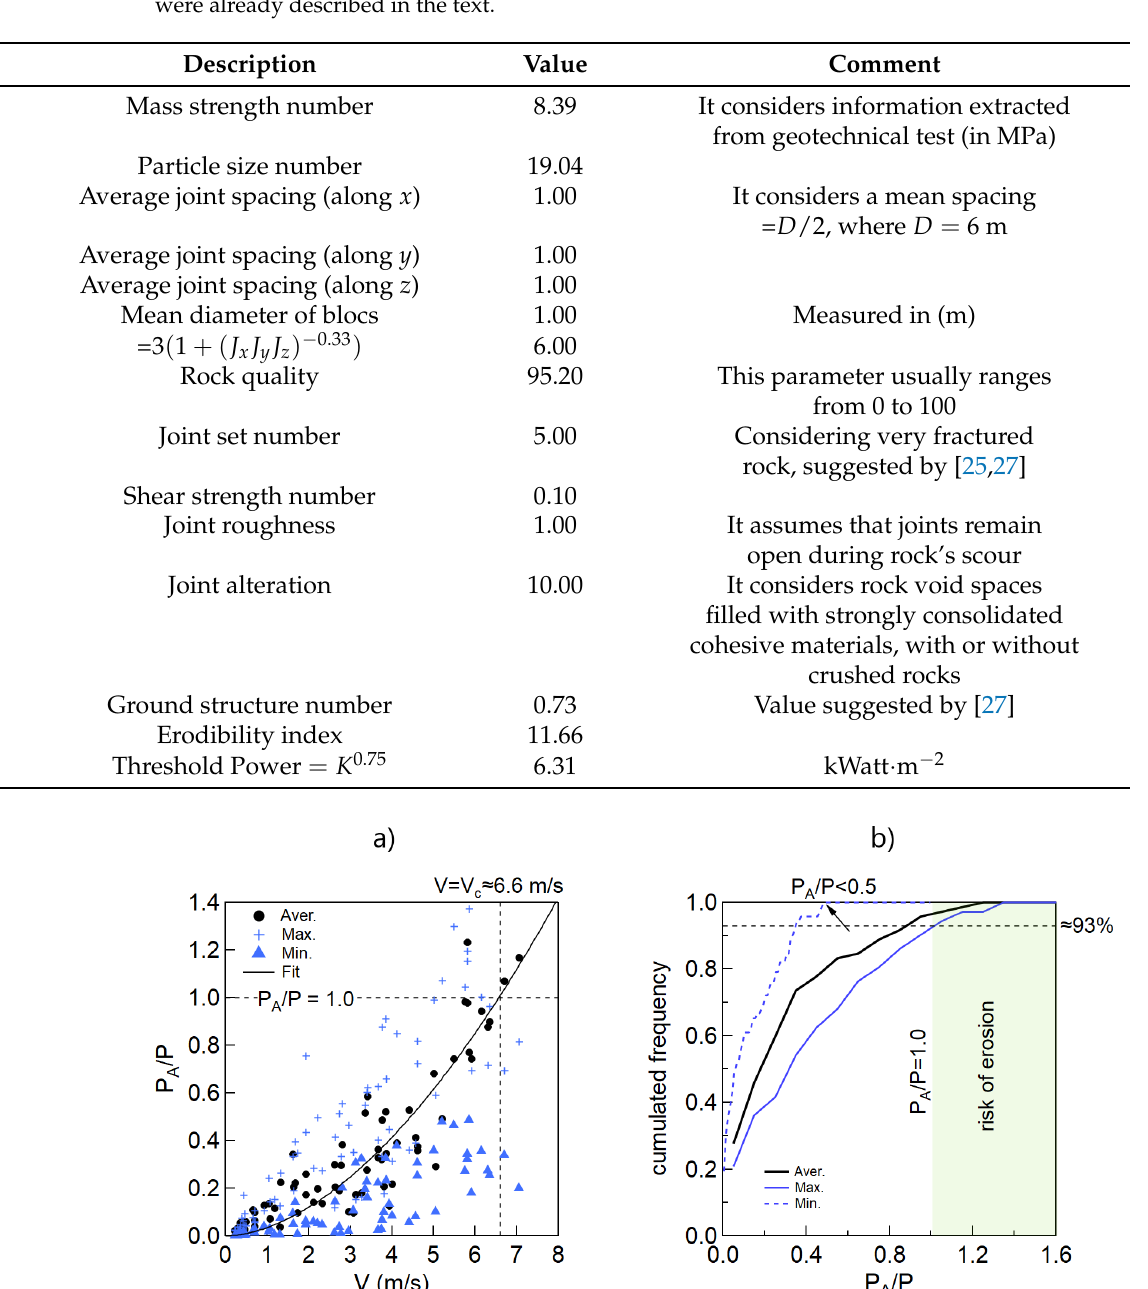
Figure 14. Erodibility at CT site. ( a ) Distribution of P A / P versus V obtained for minimum, maximum and average shear stress ( τ λ min , τ λ ave , τ λ max ). The fit corresponds to Equation (21) for averaged data. A critical “scour” velocity V c = 6.6 m/s was included. ( b ) Cumulated frequency distribution curves obtained for the ratio P A / P for the same conditions. The erosion risk region ( P A / P ≥ 1) was shown for reference (box in light